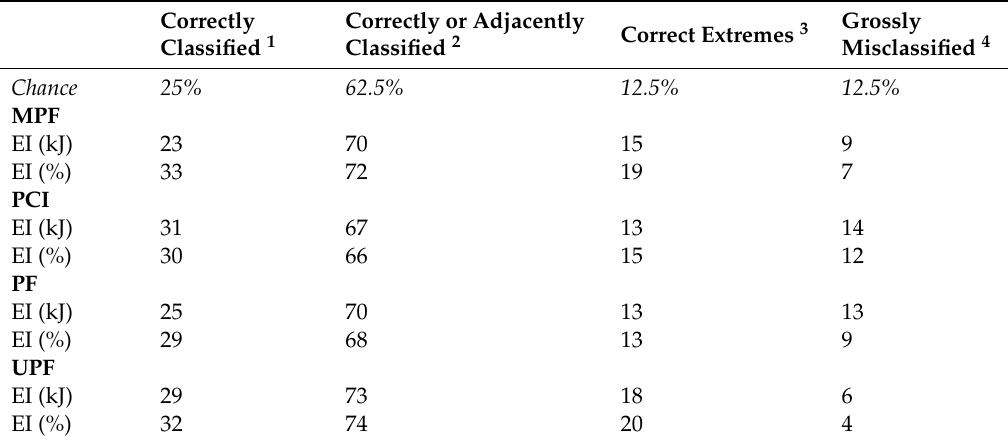
Table 3. Cross-classification of quartiles of daily energy intake from processed food categories by FFQ and WDR ( n =